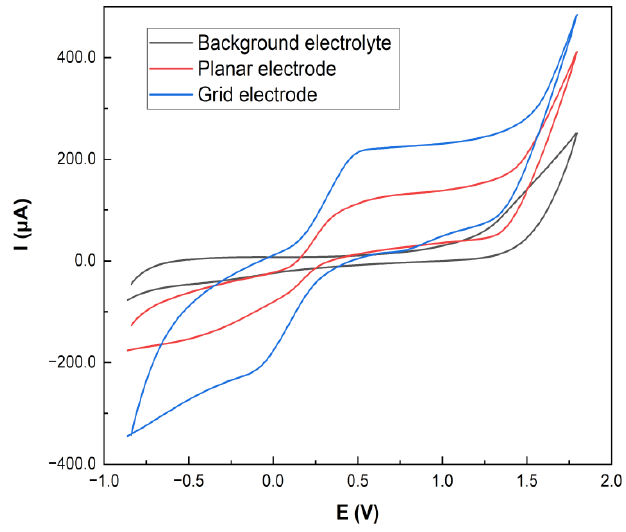
Figure 3. Cyclic voltammograms at 100 mV/s of 0.01 mol/L [Fe(CN) 6 ] 3 − /4 − solution in 0.1 mol/L KCl at planar and grid LRGO electrodes.